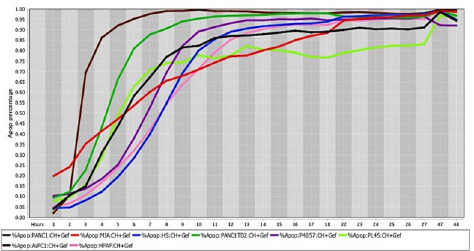
Fig 11. Cell death response curves for pancreatic cancer. Cell death response expressed in percentage of apoptosis in human pancreatic cancer cell lines (PANC1- black line, MIA Paca-2- red line, HS766T- blue line, PANC1 TD2- dark green line, P4057- purple line, PL45- neon green line, AsPC1—brown line, HPAF- pink line) exposed to CT at 20 μ M, HO-3867 at 10 μ M, and Gefitinib at 10 μ M concentration.